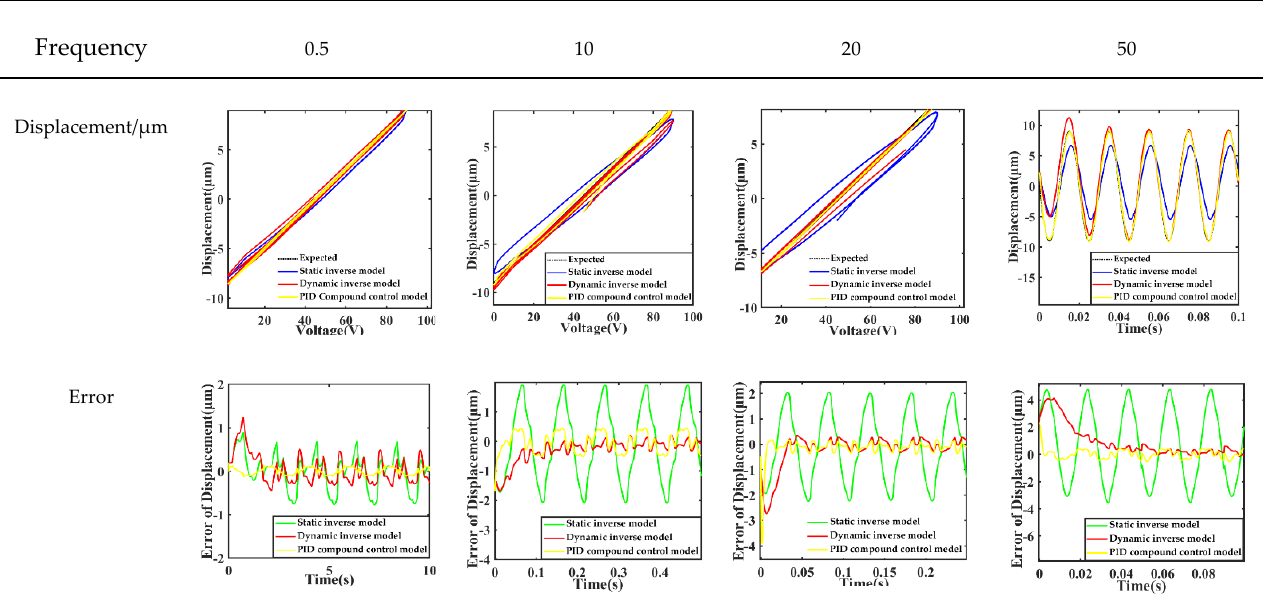
errors are listed in Table 4.